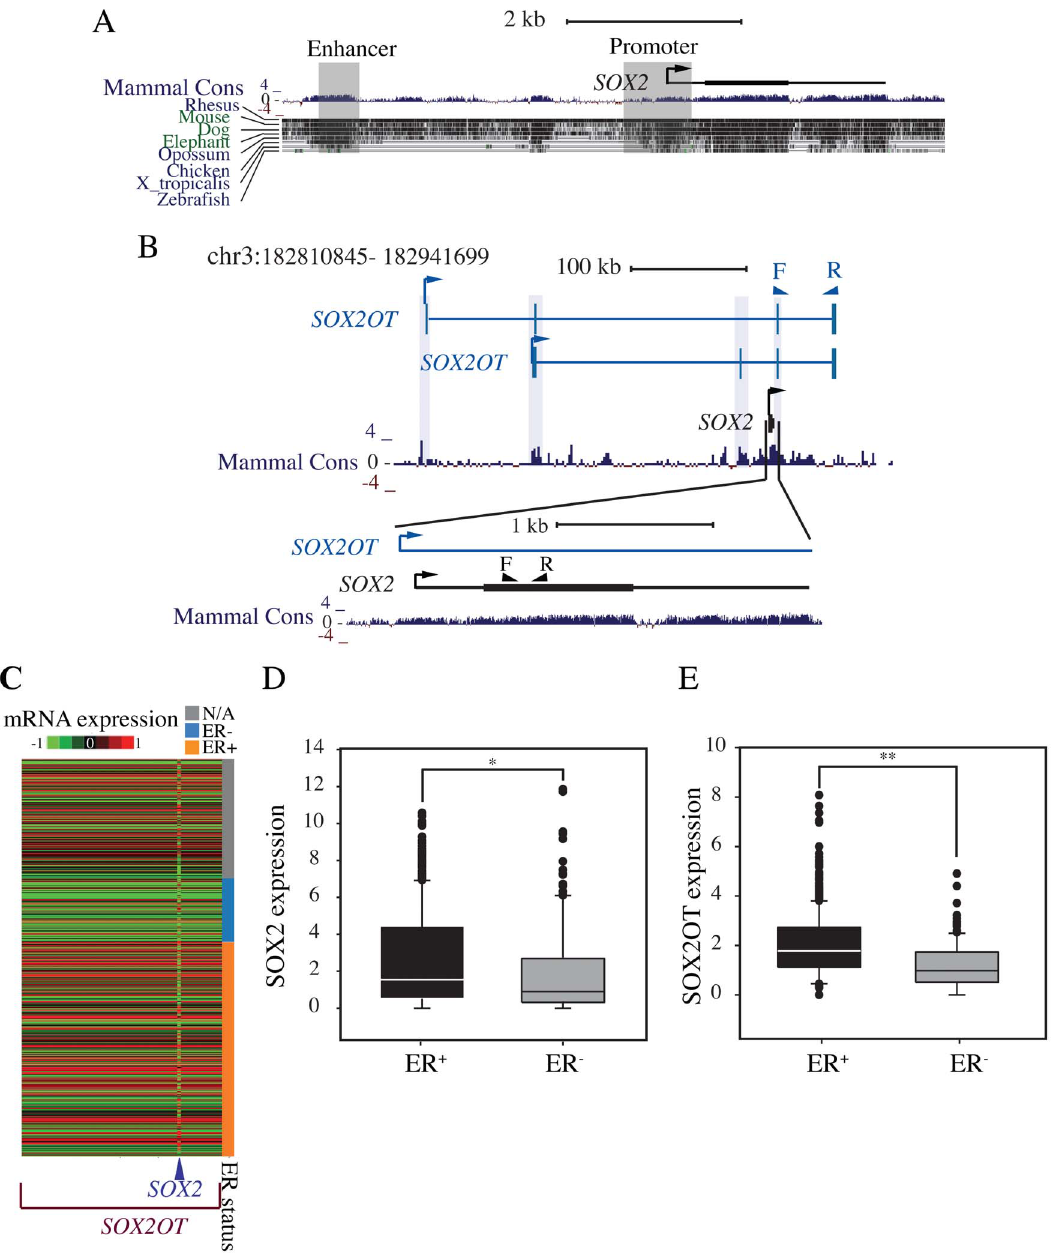
Figure 1. Schematic genomic organization of SOX2 and SOX2OT and their expression patterns in breast cancer. A) The genomic context of SOX2 and its upstream region. The gray boxes show the proposed promoter and enhancer regions [26,27]. B) The genomic context of SOX2 and SOX2OT , derived from the UCSC browser. SOX2 is located in an intron of SOX2OT . The triangles above each gene show the location of primers used in qRT-PCR. The SOX2 region is enlarged, and the direction of gene transcription shown with arrows. The phylogenetic conservation of each region is shown below the gene diagram (Mammal Cons). Vertical rectangular shading shows the conserved exonic regions of SOX2OT . The locations of these genes are adopted from UCSC genome browser March 2006 (NCBI36/hg18). C) Heat map showing the expression of SOX2 and SOX2OT in breast cancer samples analyzed by TCGA. It covers the expression of SOX2OT ; chromosome 3: 182810845–182941699. SOX2 region is shown by an arrow. The samples are classified based on the estrogen receptor status. D and E) Expression of SOX2 and SOX2OT respectively in ER + (n=595) and ER 2 (n=176) breast cancer samples (data derived from TCGA). Mann-Whitney rank sum test showed that these genes were expressed differently according to estrogen status: p values of , 0.05 and , 0.005 were calculated for D and E respectively. shown that lncRNAs genes are poorly conserved compared to protein-coding genes [33,34]. Conservation analysis of lncRNAs based on 50-nt window size revealed that many lncRNAs retain as long non-coding RNAs (lncRNAs) [29,32]. Most studies have patches of higher conservation, possibly representing interaction